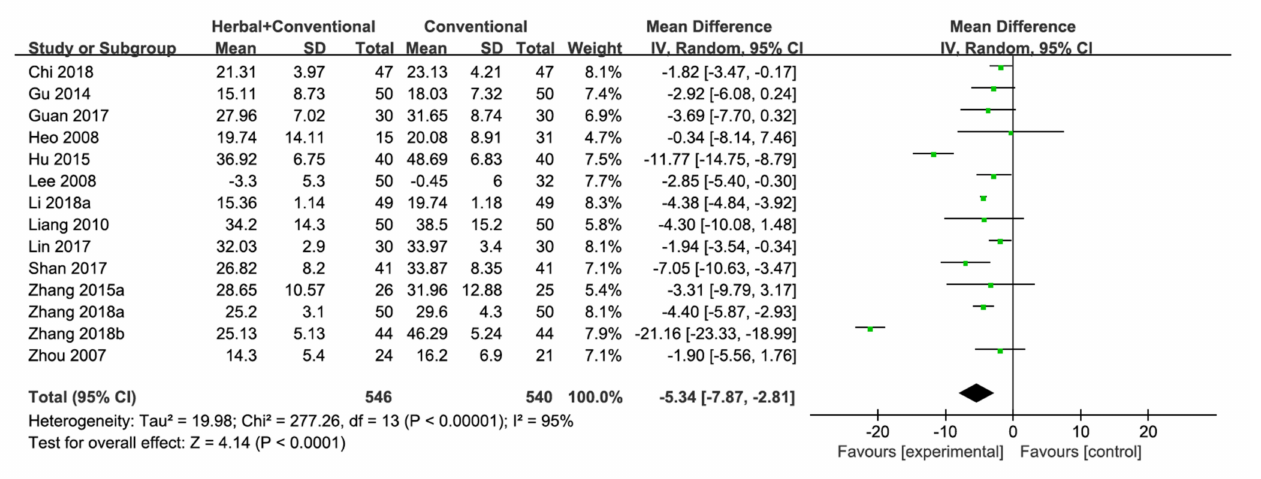
Figure 6. Forest plot for ADAS-cog: Herbal medicine + conventional medicine vs. Conventional